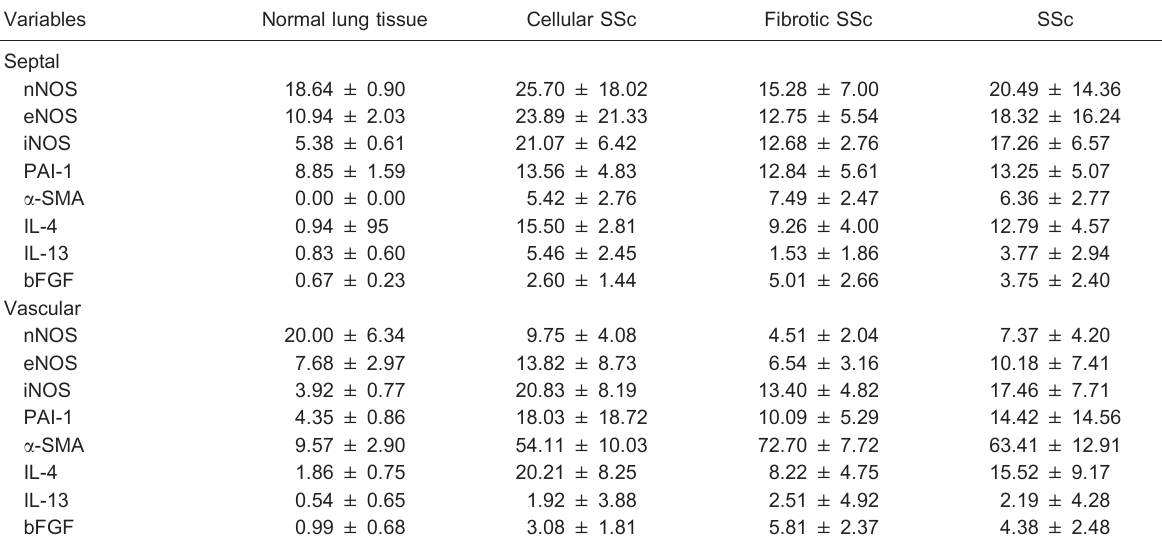
Table 2. Summary of morphometric results.